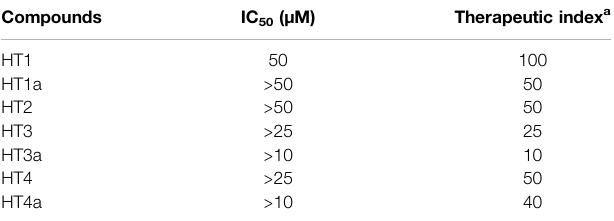
TABLE 3 | IC 50 values and therapeutic index of new donepezil hybrids.